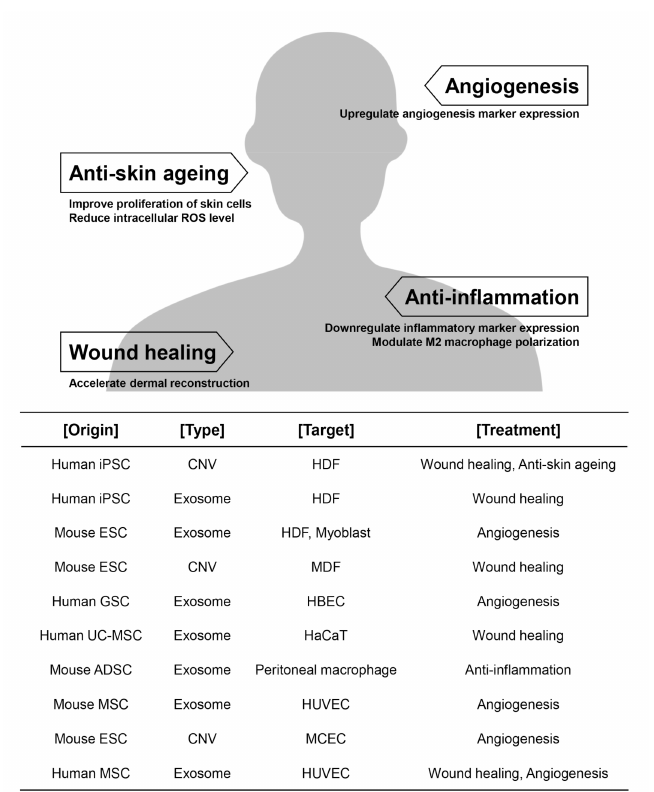
Figure 4. Therapeutic potential of nano-sized vesicles. Exosomes and CNVs derived from stem cells have therapeutic potential for not only proliferation, migration, and angiogenesis but also for treatment of wound damage, photoageing, and natural senescence. iPSC (induced pluripotent stem cell); ESC (embryonic stem cell); MSC (mesenchymal stem cell); GSC (glioma stem cell); UC-MSC (umbilical cord mesenchymal stem cell); ADSC (adipose-derived stem cell); CNV (cell-engineered nanovesicle); HDF (human dermal fibroblast); HUVEC (human umbilical vein endothelial cell); MDF (mouse dermal fibroblast); HBEC (human brain endothelial cell); HaCaT (human immortalized keratinocyte); MCEC (mouse cavernous endothelial